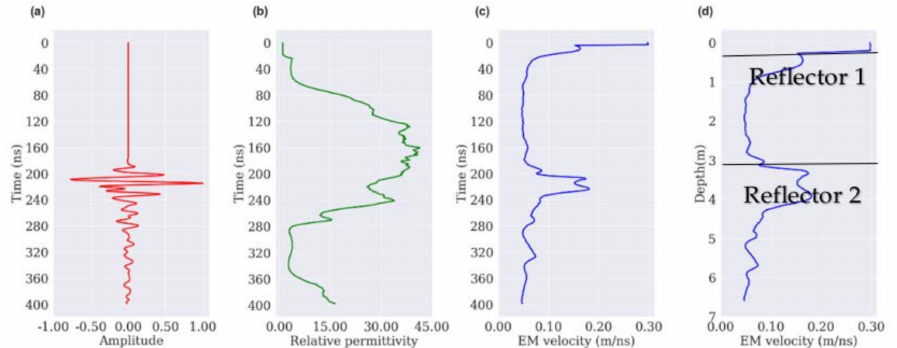
Figure 15. ( a ) GPR trace at 2.53 m offset in the time domain, ( b ) the variation of ε r in the time domain, ( c ) EM velocity in the time domain, and ( d ) EM velocity in the depth